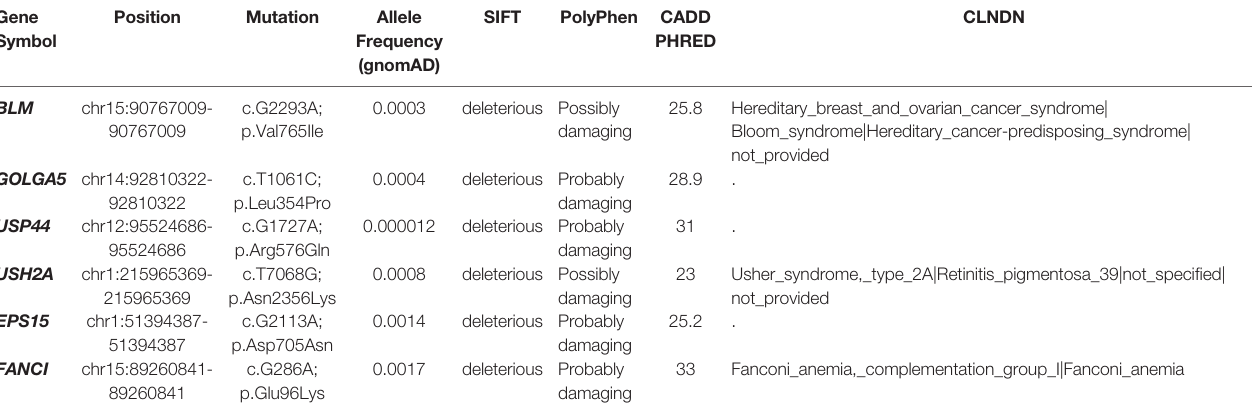
TABLE 2 | Potential pathogenic germline